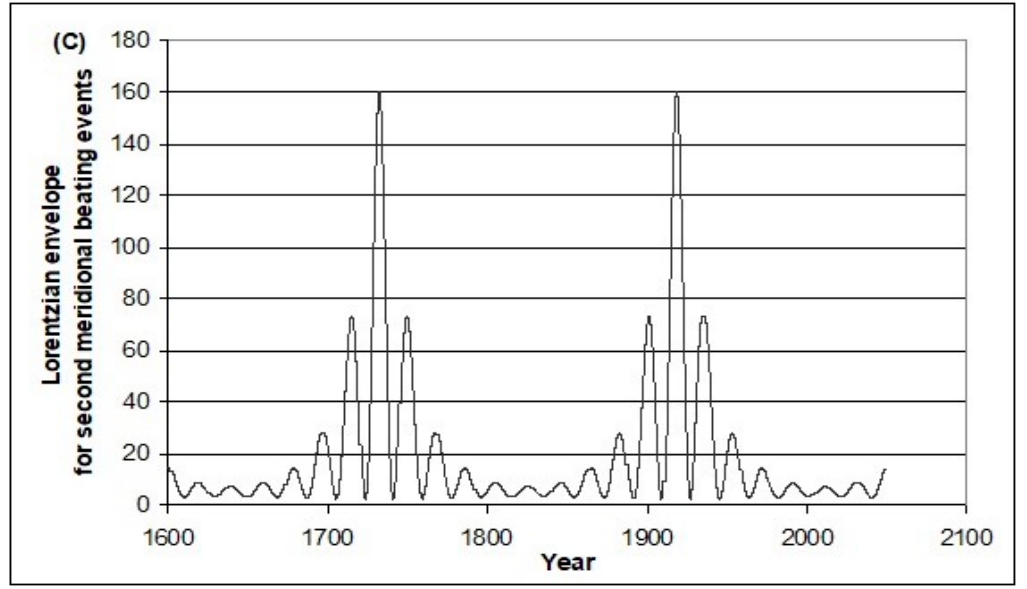
Figure A1. Lorentzian envelopes of beating events in tidal forcing for: ( A ) the 59.75-/14.94-year zonal pair; ( B ) the 86.81-/21.70-year meridional pair; and ( C ) the 186.0-/18.60-year meridional pair.